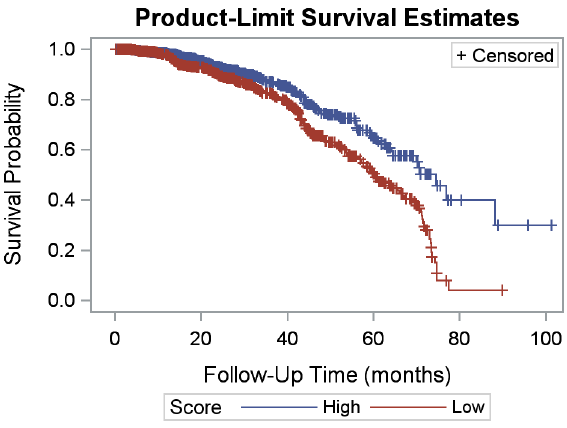
(PDF) Figure 2. Kaplan-Meier loss to follow-up by quality indicator